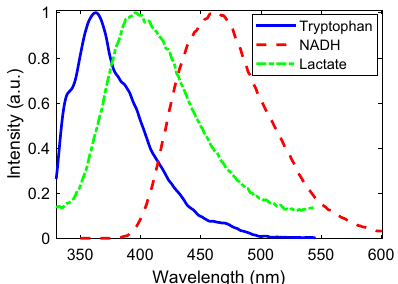
Figure 3. Fluorescence spectra of aqueous solutions of the three fluorophores.